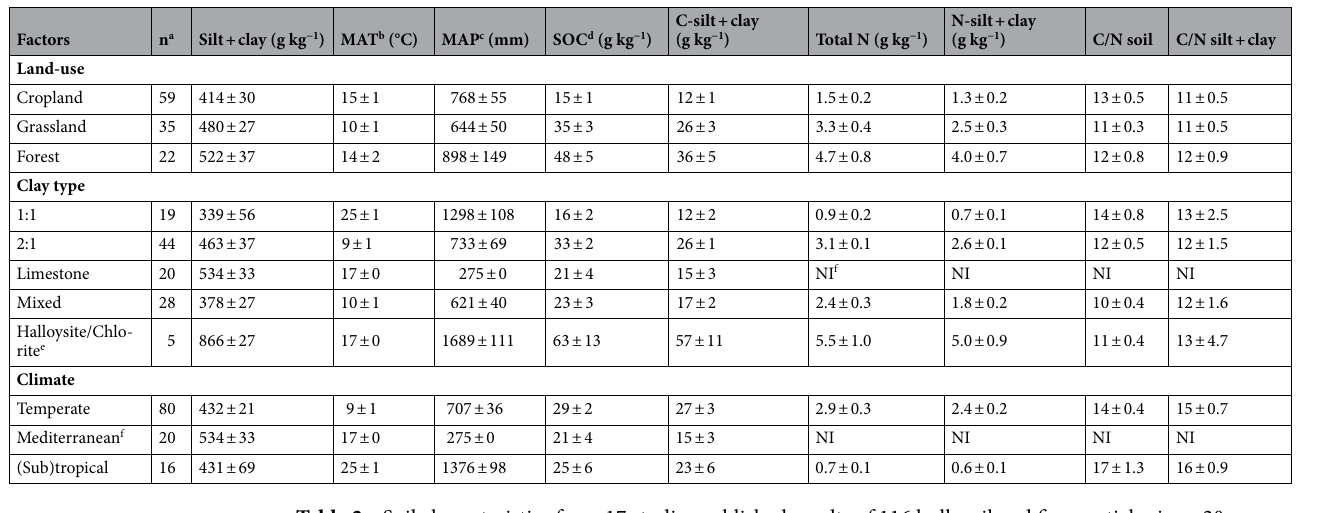
soils (Fig. 2C, Table 1). Similar patterns were observed for particles < 20 µm, with a narrower range of SOC from 4 to 103 g C kg −1 soil (Fig. 2G–I, Table 2). The total N contents varied from 2.0 to 3.7 g kg −1 soil and followed a similar pattern to that of the SOC contents, except for (sub)tropical soils corresponding to particles < 63 µm (Fig. 2D–F), for which the highest N contents were common in the grasslands (3.5 ± 0.4 g kg −1 soil) and the lowest N contents were common in the < 20 µm, with a wider range of total N content from 0.3 to 8.5 g N kg −1 soil (Table 2, Fig. 2J–L). In general, the C/N ratio ranged from 11 to 19 in the bulk soils, as in the fine fractions. For the < 63 µm fraction, the bulk soil C/N ratio decreased in the following order: forests > croplands and grasslands, but this decrease was more pronounced in the silt + clay particles (Table 1, Fig. 2). For the < 20 µm fraction, the highest C/N ratios were commonly found in the tropical and temperate climates (Table 2, Fig. 2). Organic carbon and total nitrogen in bulk soil and in the silt + clay fraction. A linear regression (Eq. 1) was used to test whether the soils had similar percent increases of C and N in the fine fractions to the SOC and total N contents in the bulk soils. This method requires independent data in the regression. Nonindepend- ence may occur within studies (e.g., due to sampling and analytical errors) and between studies (e.g., studies of the same laboratory group) or when using data from repeated authors. To account for nonindependence, the linear mixed model approach was used 77 . Land use and SOC content were treated as fixed effects, and the authors were treated as random effects. Authorship was not significant ( p > 0.087) for the whole model effect. The observed Chi 2 distribution of the data was significant ( p < 0.022); i.e., the data fitted the expected distribution of independent data. ANOVA was used to explore the random effects of the whole model using a Type I error. A significant random effect (rejection of the true null hypothesis) indicates the nonindependence of the dataset. ANOVA based on a Type III error was performed to examine the significance of the fixed effects of the model. In general, all categorical factors (land use, clay mineralogy and climatic factors) presented highly significant effects for the whole model ( p < 0.001). Given the lack of a significant random effect, the regression analysis was performed on the studies using the standardized sonication method. A positive and highly significant ( p < 0.001) regression was found for particles < 63 µm in each categorical factor (land use, clay mineralogy and climatic factors) using the SOC and total N con- tents (Fig. 3). The adjusted R 2 values ranged between 0.91 and 0.99, and the intercepts y o were not significant (no different from zero) (Table 3). The regression slopes (Eq. 1) ranged between 0.72 ± 0.03 and 0.88 ± 0.04, reflecting that 72–88% of the total C and N contents were bound by silt and clay. Low RMSE values were recorded. The predicted error of measured SOC in this fraction ranged from ± 8.3 to ± 11.7 g kg −1 (average of ± 9.0 g kg −1 ), two times lower than the computed standard deviation (± 19.8 g kg −1 ) of the original data. For the sensitivity analysis, the output changes (%) between the original and predicted C-silt + clay contents were calculated while omitting the SOC contents one at a time, and the regression was computed again (total N not shown). The output changes for the fractions < 63 µm and < 20 µm varied between − 0.6% and 0.9 and had a normal distribution using absolute and log-transformed data (Fig. S1, see “Supplementary Information S1”).